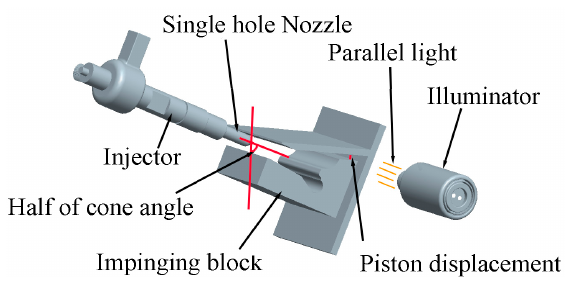
Figure 7. Schematic diagram of the spatial relationship of the injector, impinging block and illuminator.